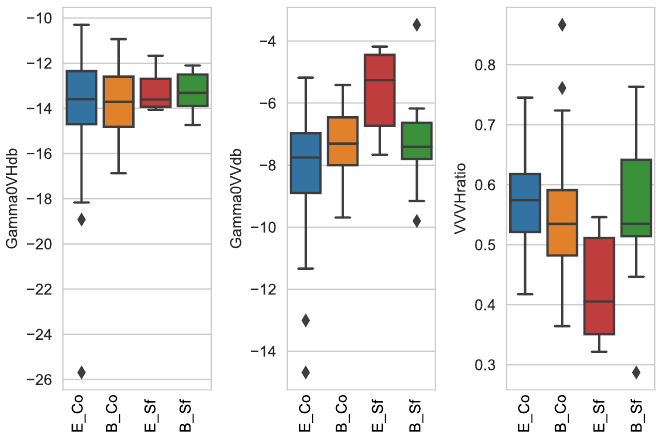
Figure 8. Boxplot distribution of backscatter the significant stepwise regression predictor variables, aggregated at four land use categories (a combination of site and land use), based on model B (Figure